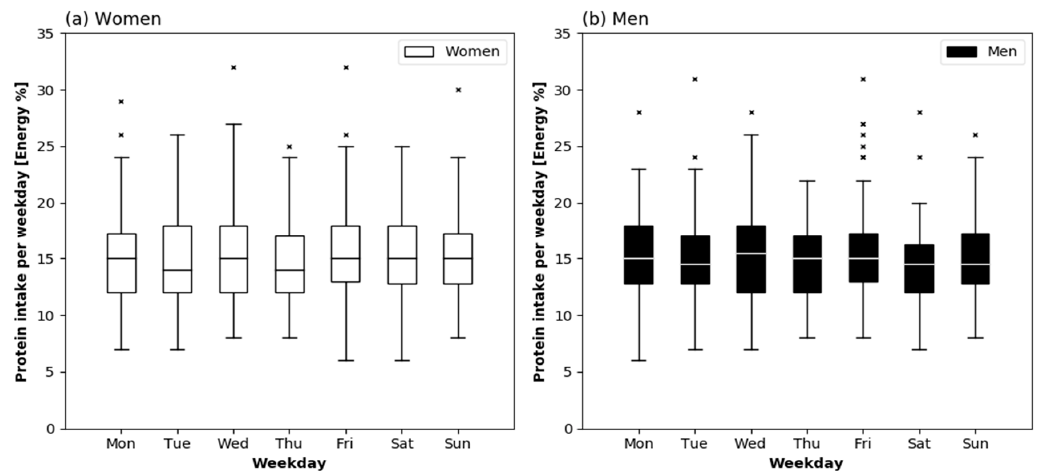
Figure 2. Daily Protein intake in percent of total energy intake by weekday in healthy community-dwelling older women ( n = 72) ( a ) and men ( n = 68) ( b ). Friedman’s test: p = 0.705 in women, p = 0.557 in men. The boxes represent interquartile ranges with the horizontal lines denoting the median. The whiskers show the highest and lowest values within the 1.5-fold interquartile range. The × represent outliers.